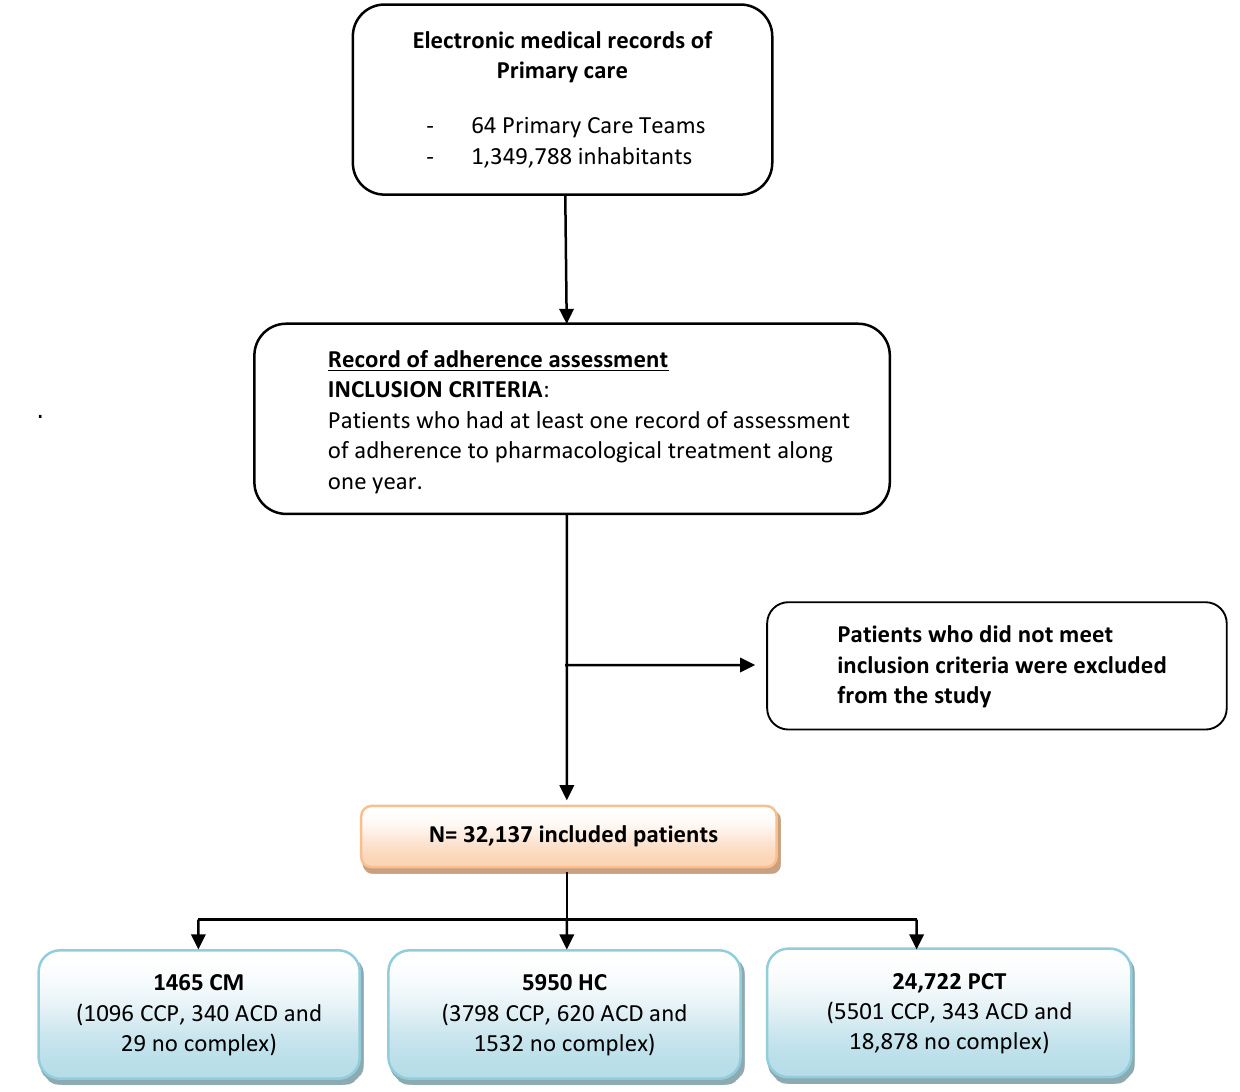
Figure 1. Flow chart of patient inclusion at each point of the study